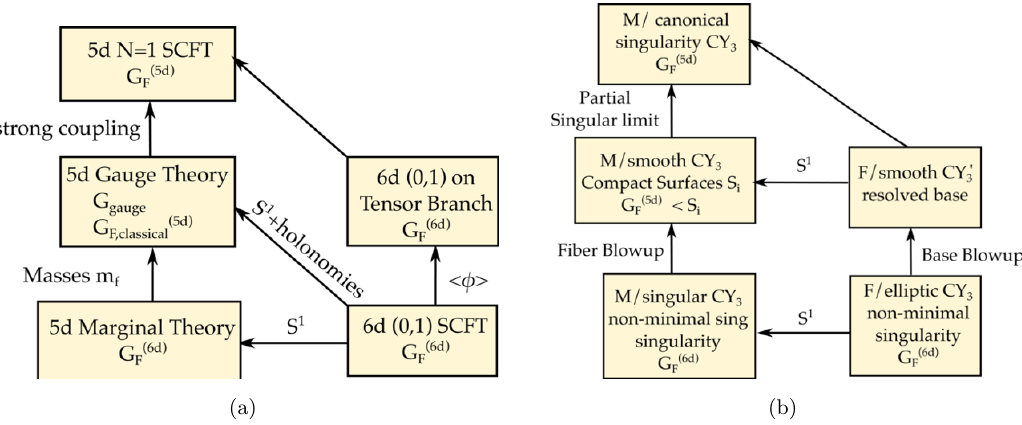
Figure 1 . (a) Field-Theory overview: starting from a 6d SCFT, the circle-reduction yields the 5d marginal theory. Mass deforming the marginal theory gives rise to 5d gauge theories that (cid:13)ows to 5d SCFTs in the UV. Alternatively, one can reduce the 6d theory on a circle with holonomies and then (cid:13)ow to said SCFTs. A third alternative is to take the 6d SCFT onto the tensor branch and reduce to 5d. (b) Geometry overview: the geometric realization in F/M-theory complements the (cid:12)eld theoretic approach. A 6d SCFT is constructed from F-theory on a non-compact elliptically (cid:12)bered Calabi-Yau threefold CY 3 with non-minimal singularities. These have crepant resolutions either by blow-ups in the (cid:12)ber (an approach useful e.g. for conformal matter theories) or by blow-ups that modify the base of the (cid:12)bration. Each of these approaches introduces compact surfaces, S i , and the 5d strongly coupled (cid:13)avor symmetry is encoded in the geometry of certain curves associated to the 6d (cid:13)avor symmetry inside the surfaces S i . We propose a succinct way of tracking these, so-called (cid:13)avor curves, in terms of a graphical tool, making G (5d) that is encoded in the geometry manifest F | see (cid:12)gure